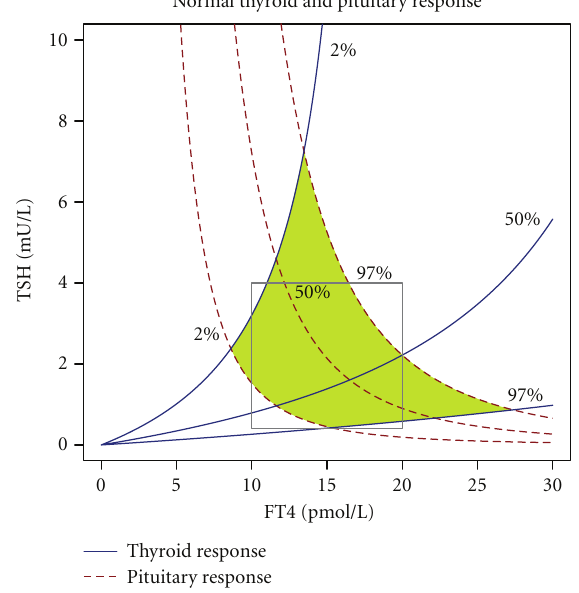
Figure 9: Comparison of conventional univariate reference ranges for TSH and FT4 (grey box) and a bihormonal reference region (green kite-like area) from nonlinear modelling of thyroid home- ostasis. For more information see text and legend of Figure